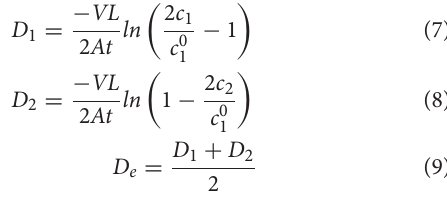
Frontiers in Built Environment |